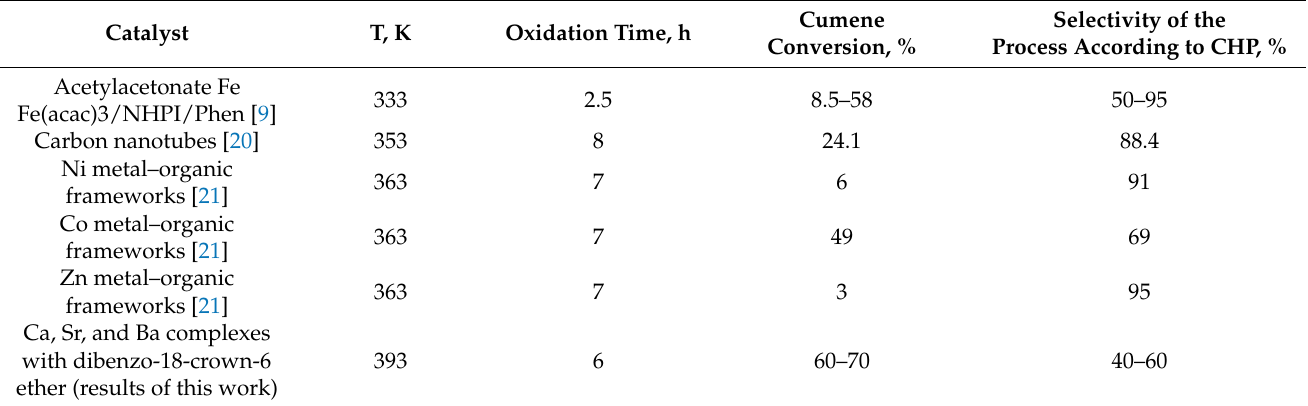
Table 1. Cumene oxidation in the presence of various catalysts ([RH] 0 = 0